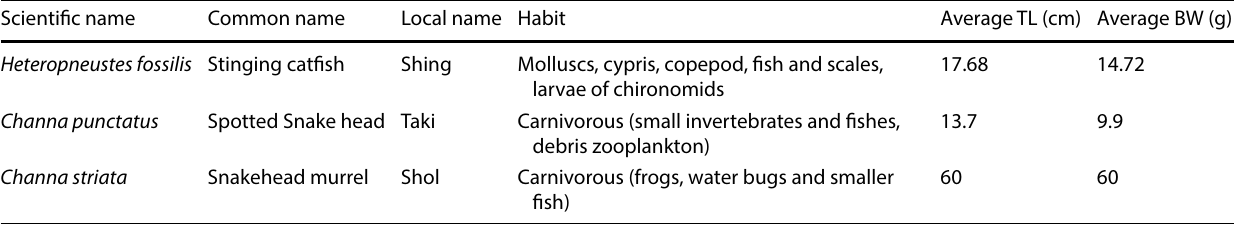
Fig. 1 Study area Table 1 Basic biological parameters of three selected fish species [36,